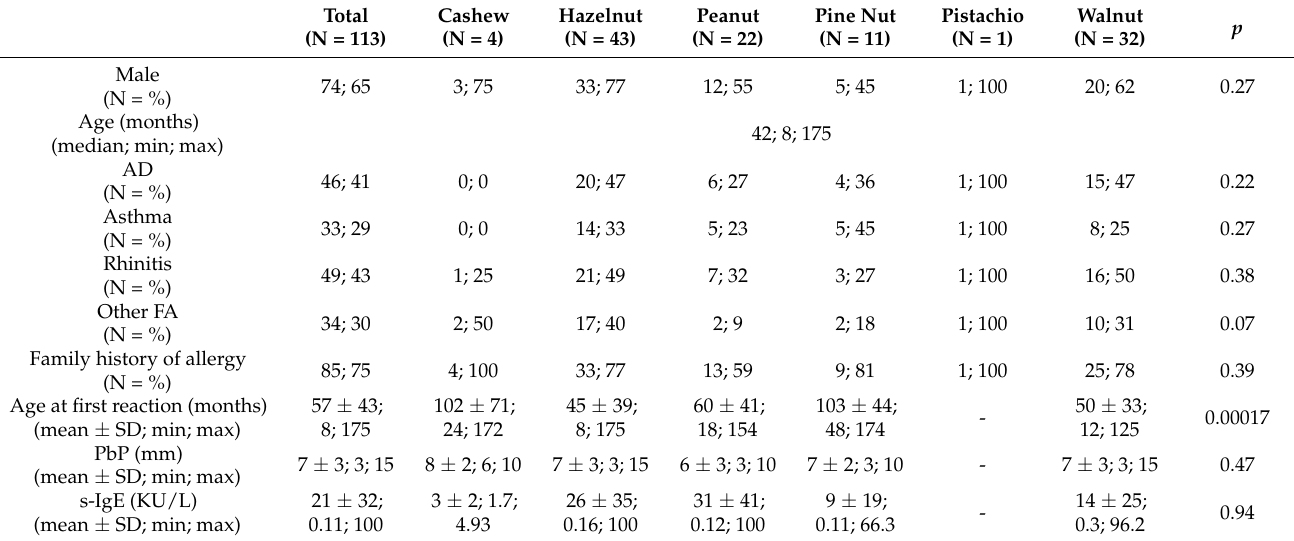
Table 2. Demographic characteristics of patients with a nut allergy.